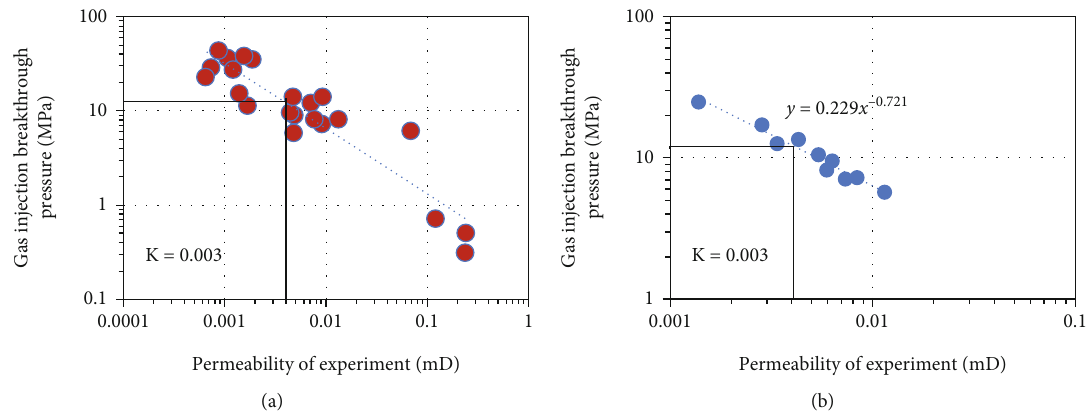
Figure 18: Intersection of permeability and gas injection breakthrough pressure: (a) core experiment; (b) digital core simulation.